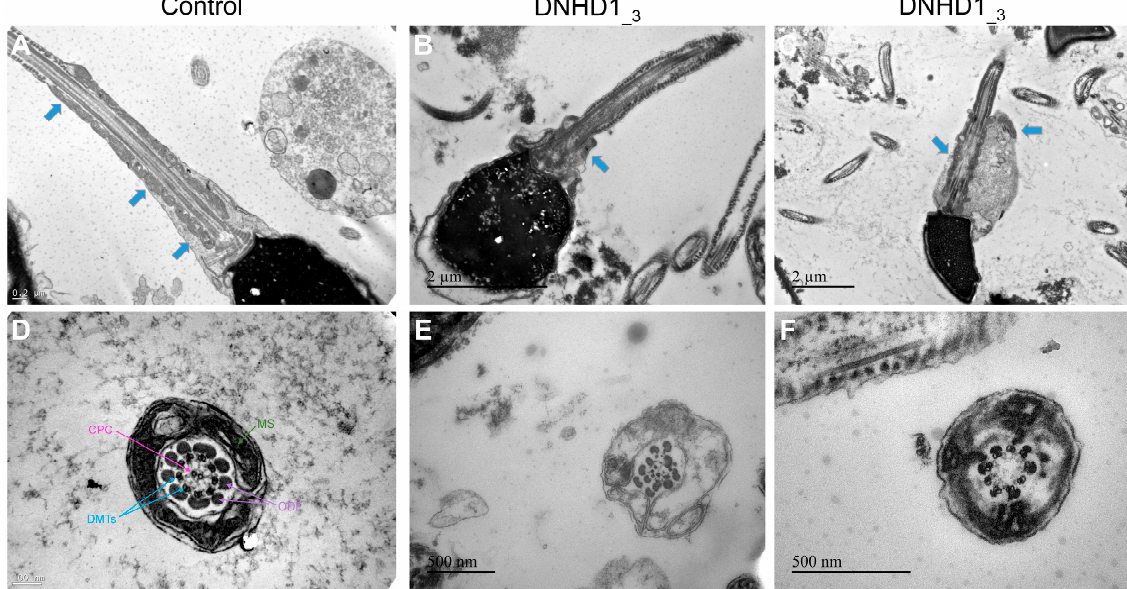
Figure 3. Transmission electron microscopy analyses of sperm cells from a control individual ( A , D ) and the patient DNHD1 _3 ( B , C , E , F ). In longitudinal sections ( B , C ), a short tail can be noticed corre- sponding to a cytoplasmic mass containing the different components of the flagellum, all disorganized. In addition, severe midpiece defects are present with a shortened and misshapen mitochondrial sheath. In cross-sections of sperm flagellum from the patients ( E , F ), some sections displayed a 9 + 0 axoneme lacking the central pair complex with an abnormal number of outer dense fibers. CPC: central pair complex; DMTs/peripheral doublet microtubules; MS: mitochondrial sheath; ODF: outer dense fibers. Blue arrows mark the mitochrondrial sheath in longitudinal sec- tions. and was reported for few genes such as CFAP65 [30]. It has also been previously suggested that the absence of DNHD1 may disrupt the interaction with proteins involved in the in- tra-flagellar transport (IFT) process or affect the expression of IFT-related proteins leading to the abnormal flagellar assembly and, in particular, to the peri-axonemal defects [29]. To explore this assumption and to evidence a possible interaction between DNHD1 and CFAP65, subsequent study of the presence and localization of the IFT-related proteins IFT20 and CFAP65 were investigated. However, immunostaining for IFT20 and CFAP65 were similar to controls, indicating that IFT does not seem to be affected by DNHD1 mu- tations and that CFAP65 does not directly interact with DNHD1 into the same axonemal complex (Figure 4).